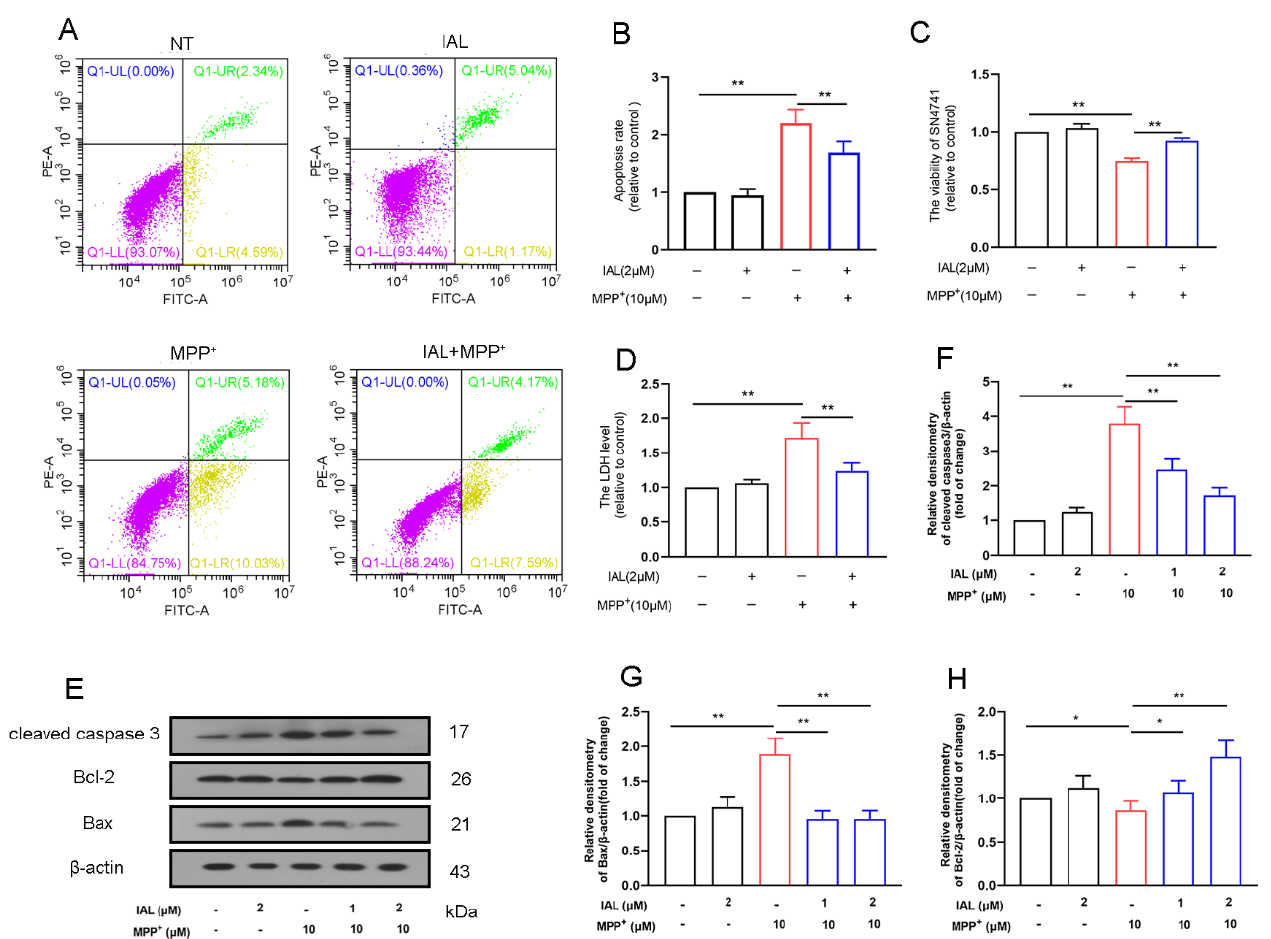
Figure 4. IAL reduces the cells death in MPP + -exposed SN4741 cells. ( A , B ) The effect of IAL on MPP + -induced SN4741 cell death was examined using flow cytometry. ( C ) The effect of IAL on cell viability was examined in MPP + -exposed SN4741 cells using the CCK-8 method. ( D ) The effect of IAL on cellular LDH release was examined in MPP + -exposed SN4741 cells using the LDH method. ( E – H ) The effect of IAL on apoptosis-related proteins in SN4741 was analyzed with the Western blot method. Results are presented as means ± SEM (n = 3). * p < 0.05 and ** p < 0.01 stand for biologically significant differences.